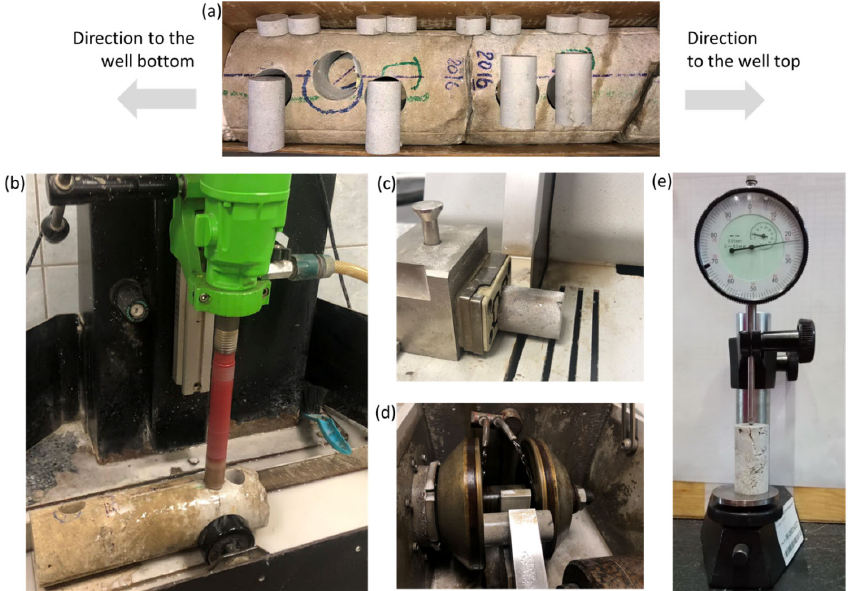
Figure 1. Photographs depicting the sample preparation steps: ( a ) the core from a production well; ( b ) drilling out the sample; ( c ) cutting the sample; ( d ) grinding the ends of the sample; ( e ) sample measurement.